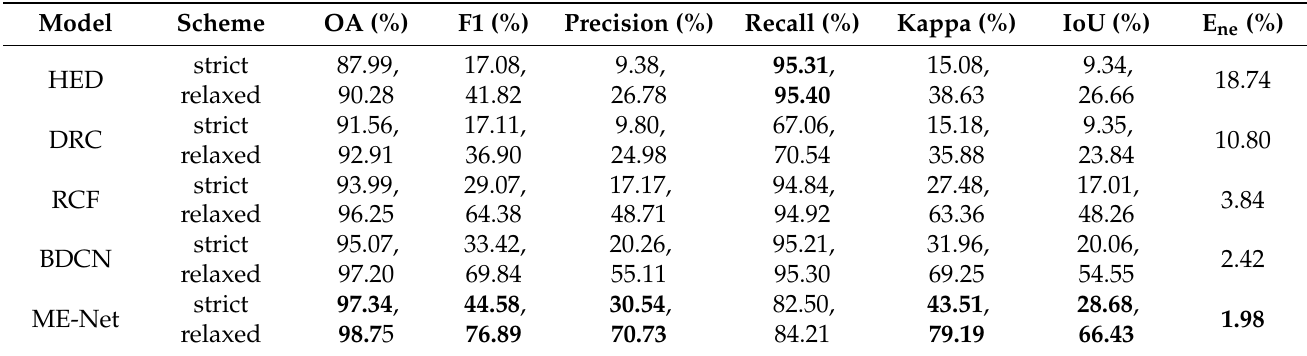
Table 2. Evaluation results on the test set of Jiangbei New Area dataset. Each cell has the value with strict and relaxed metrics and the best values are masked as bold (the lowest E ne indicates the clearest and crispest result).